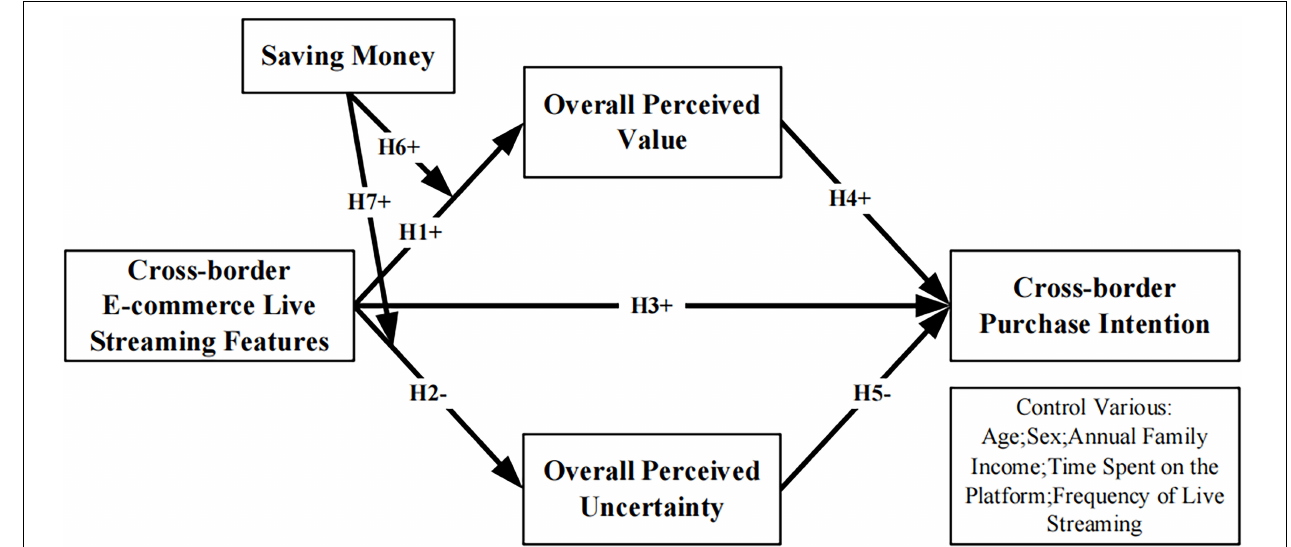
FIGURE 1 | Research